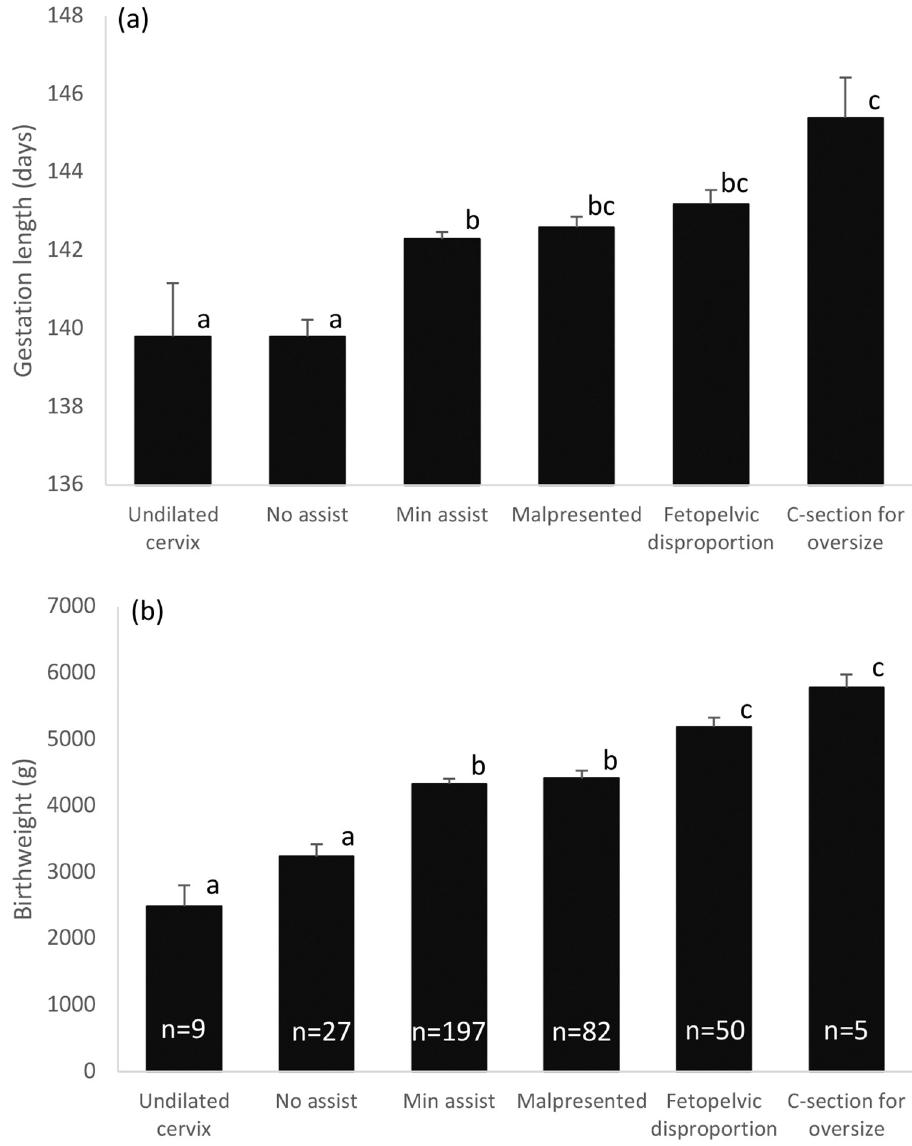
Fig 2. Gestation length and birthweight in relation to dystocia category. Average lamb birthweight (a) and gestation length (b) in relation to degree of assistance required at delivery, and the main underlying cause. Where superscript letters differ P <